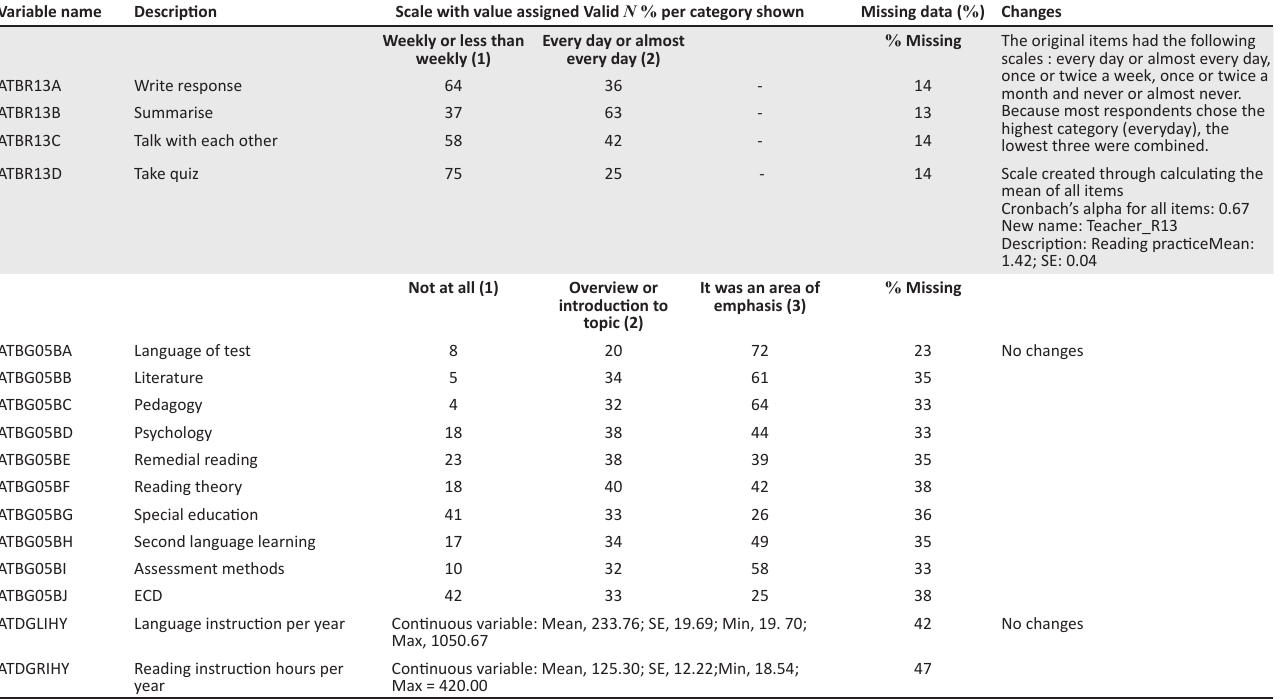
TABLE 1-A1 (Continues...): Summary of descriptive statistics of predictor used in regression